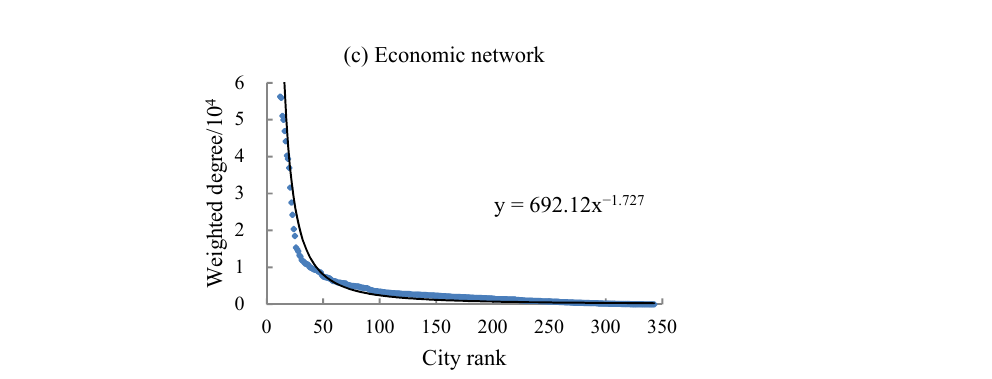
Figure 5. Weighted degree distribution of urban networks: ( a ) information network; ( b ) transportation network; ( c ) economic network.